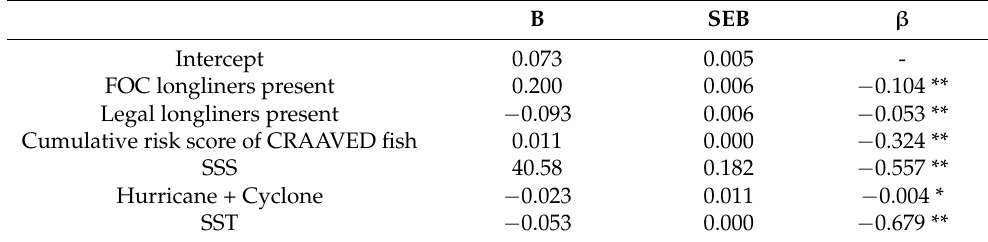
Note: R 2 = 0.285; adjusted R 2 = 0.285; F (5, 159,086) = 12,662, p < 0.01; ** p < 0.001; * p <